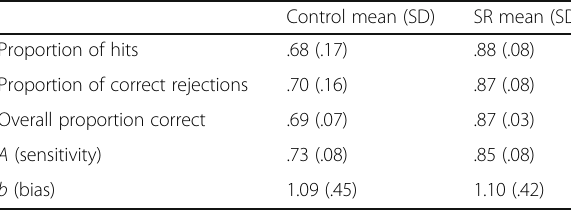
Table 3 Breakdown of performance on the pairs matching